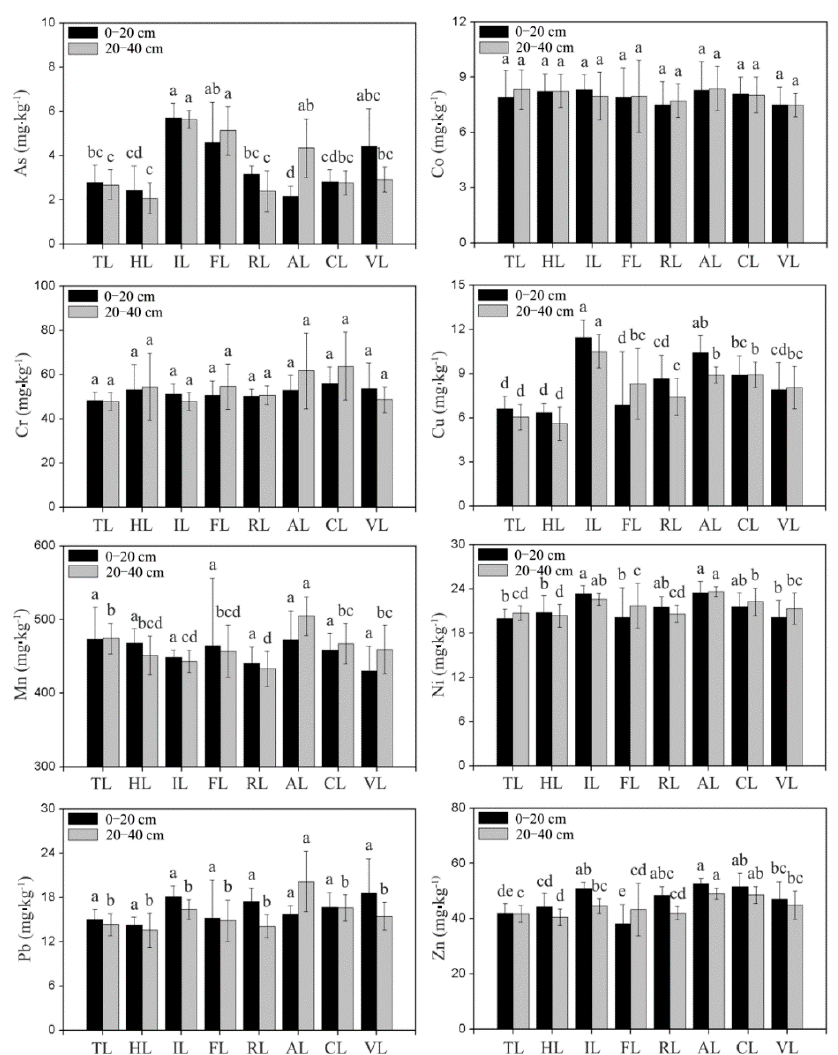
Figure 3. Enrichment of soil PHEs under different land use (TL: Tideland; HL: Halophyte land; IL: Industrial land; FL: Forestland; RL: Residential land; AL: Aquaculture land; CL: Cropland; VL: Vegetable land; Values are means of three replicates ± S.D; error bars refer to standard deviation; values having different lowercase letters indicated differences significantly (LSD, p < 0.05).